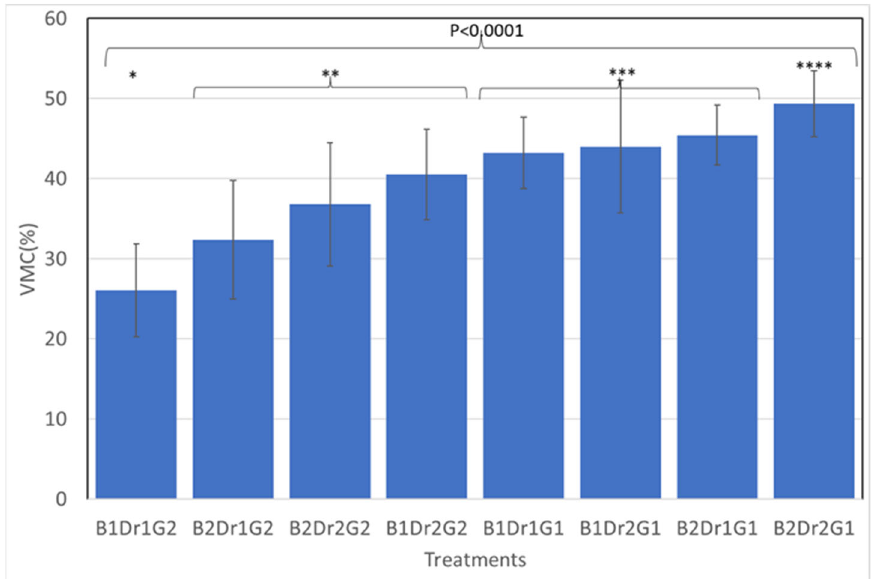
Figure 3. The mean of triple interaction blocks × drainage × geotextile for volumetric moisture content (VMC %) B1: 3 March; B2: 30 March; Dr1: without drainage package, Dr2: with drainage package; G1: without geotextile; G2: with 2 kg/m 2 of geotextile. The stars indicate significant statistical di ff erences (*). (Numbers of asteriks *, **; *** ; **** indicates p -value).